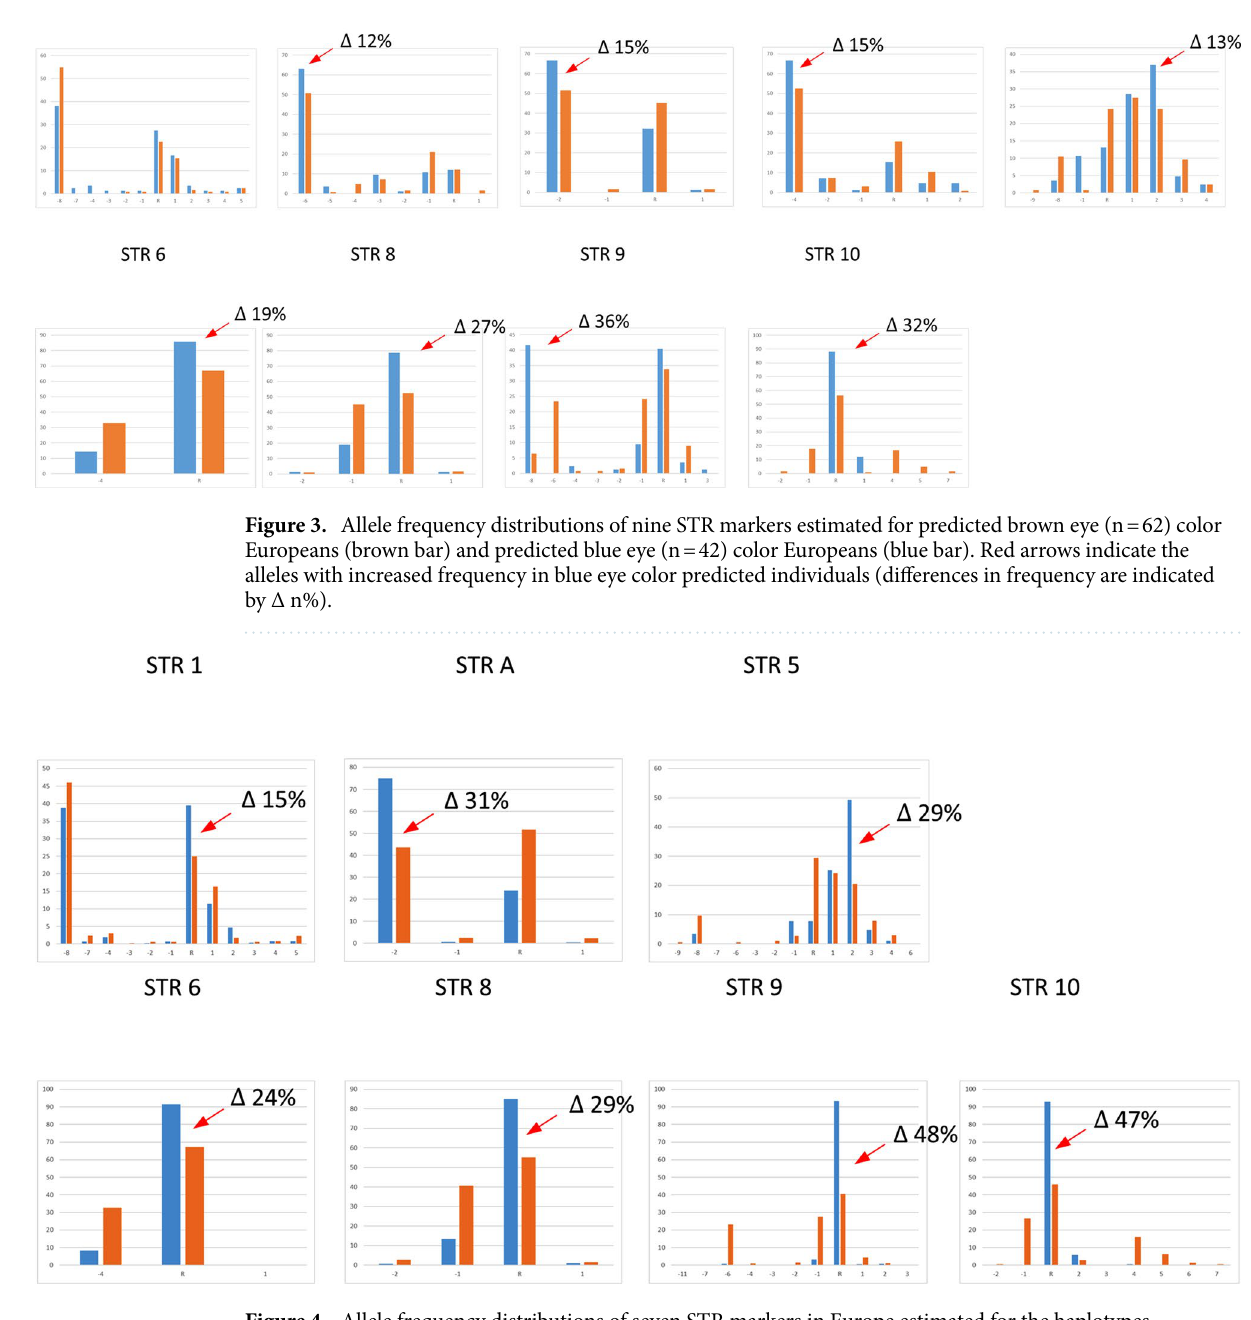
Figure 4. Allele frequency distributions of seven STR markers in Europe estimated for the haplotypes containing the functional allele rs12913832 C (blue bar, n = 1105 European haplotypes) and for haplotypes containing the alternative variant rs12913832 T (brown bar, n = 641 European haplotypes). Red arrows indicate the alleles with increased frequency in the group of haplotypes carrying the functional variant for blue eye color (differences in frequency are indicated by Δ n%). STR 2 and STR B are not reported because of the large proportion of missing data in the gnomAD